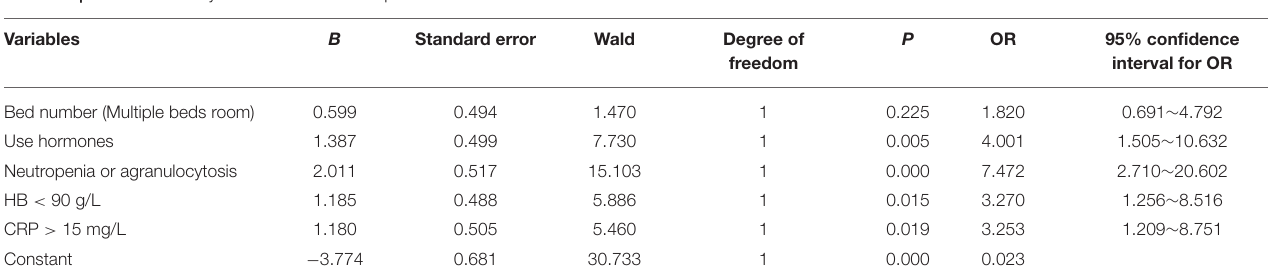
TABLE 3 | Multivariate analysis of ALL with severe